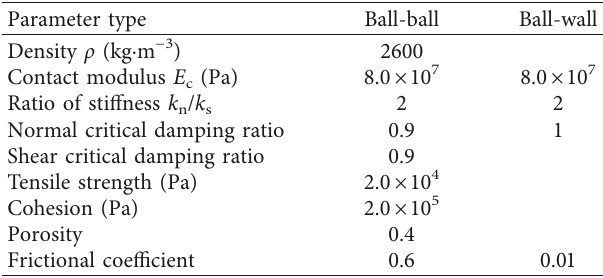
Table 1: Micromechanical parameters used in DEM